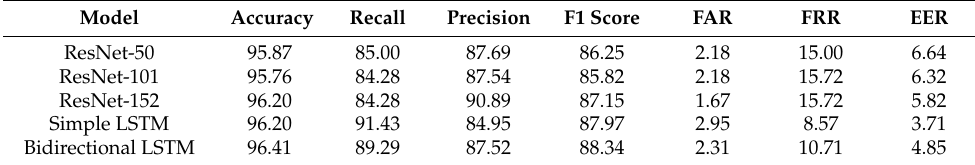
Table 3. Performance of user authentication in the targeted box and block test (Experiment 1).